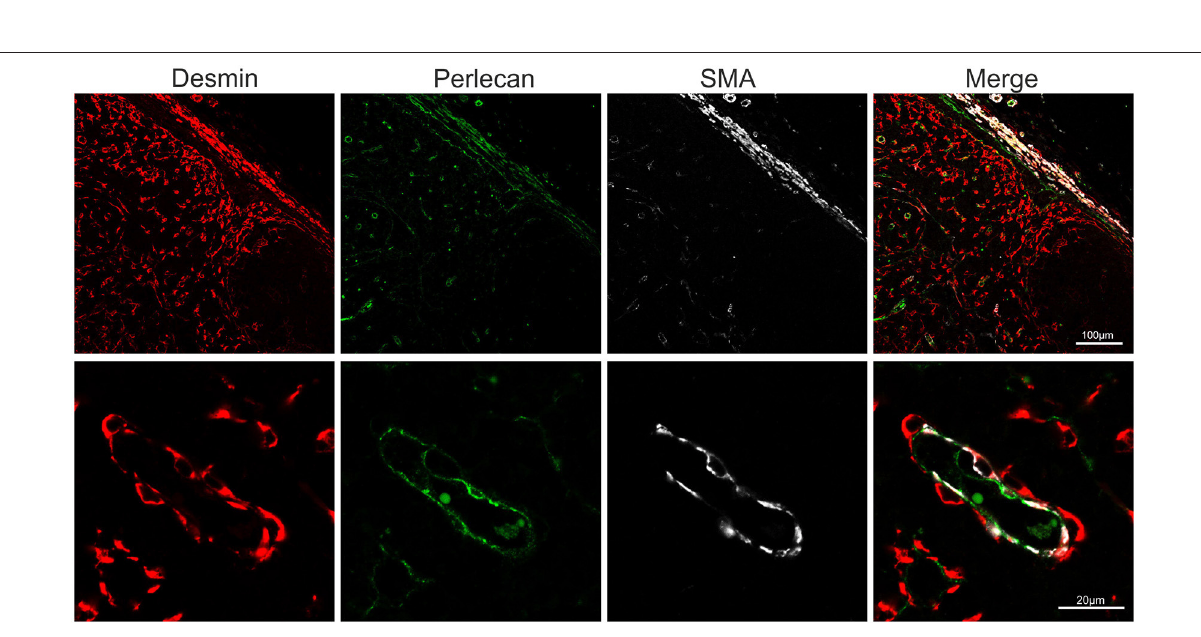
FIGURE 8 | Markers for basal membrane and pericytes. Representative confocal microscopy micrograph of sheep lymph node sections stained for desmin (rabbit polyclonal, red), perlecan (green) and SMA (white) to reveal the three-layered organization of the subcapsular sinus and of the high endothelial venules in the cortical area of the lymph